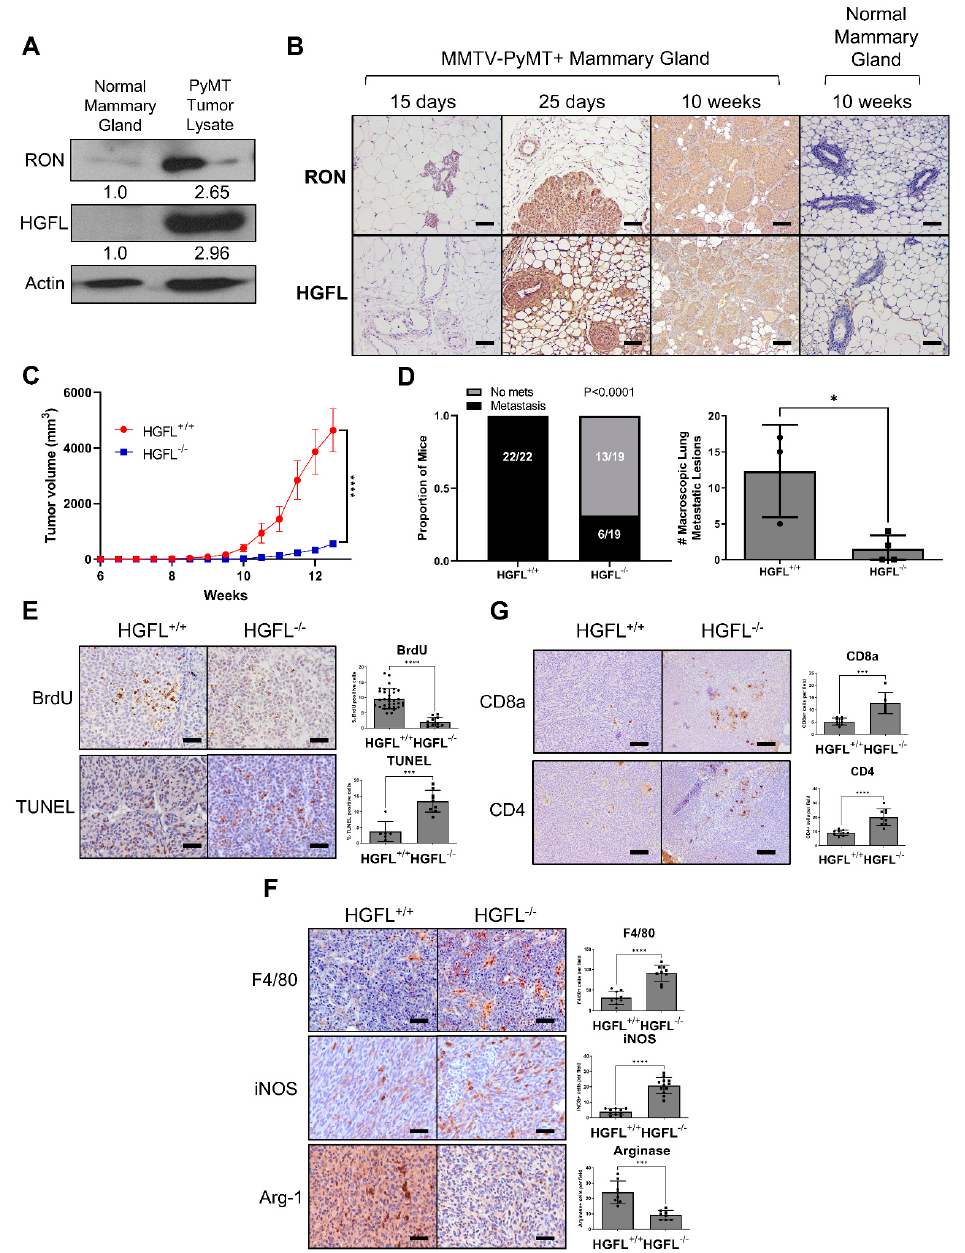
Figure 1. RON and HGFL overexpression co-occur in the murine MMTV-PyMT model of breast cancer and global HGFL deletion impairs tumor growth and metastasis and improves immune cell recruitment. ( A ) Representative western blot for RON and HGFL on lysates from normal mammary glands or PyMT tumor-bearing mammary glands of FVB mice (n = 2). ( B ) Immunohistochemistry staining for RON or HGFL on PyMT tumor-bearing mammary glands or mammary glands of non- transgenic (normal) FVB mice at specified ages (n = 4). ( C ) Tumor growth kinetics of HGFL proficient (+/+; n = 12) or HGFL deficient ( − / − ; n = 10) PyMT mice and ( D ) respective metastatic incidence and number of metastases in the lungs taken at 90 days of age. ( E ) Representative images and quantitation of specified staining for BrdU and TUNEL, ( F ) F4/80, iNOS, and Arginase-1, and ( G ) CD8a and CD4 in the mammary glands of PyMT (HGFL +/+ or HGFL − / − ) mice at 90 days. Comparisons of histological samples between groups were analyzed using Student’s t -tests. * p < 0.05; *** p <